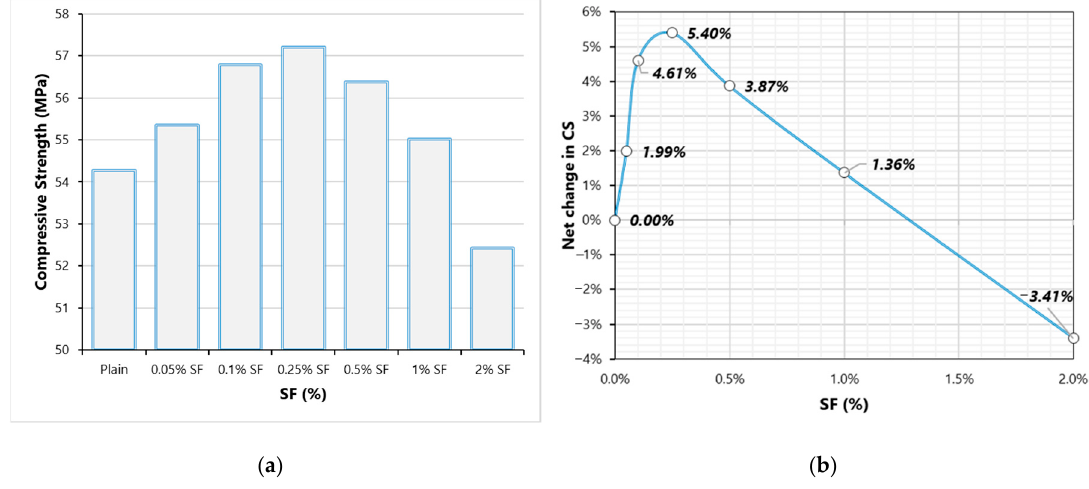
Figure 3. Compressive strength (CS) results ( a ) Variation of CS with SF dosage ( b ) Net change in CS with varying SF dosage.